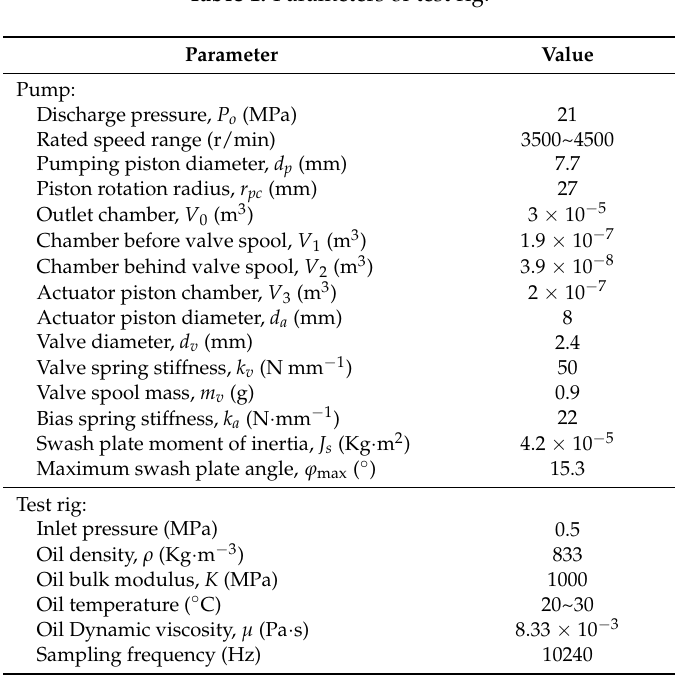
Figure 4. Measurement schematic of the swash plate angle. Table 1. Parameters of test rig.